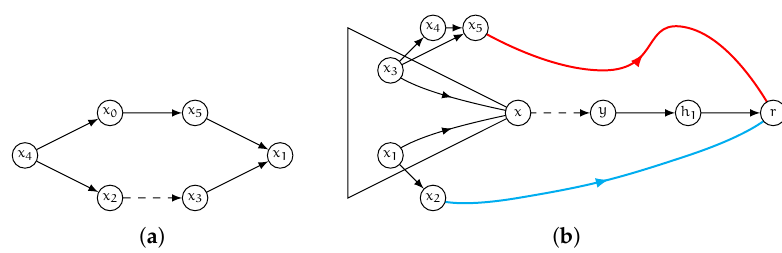
Figure 6. ( a ): an example of the contradiction reached in the proof of Lemma 3. Suppose vertex ordering is { x 0 , x 1 , x 2 , ... , x 5 } and all arcs weight 1 . Therefore, in any minimal well-ordered 2- HOP - COVER labeling, entry ( x 1 , δ x cannot belong to L out ( x 4 ) , due to the pruning test succeeding because of x 0 4 x 1